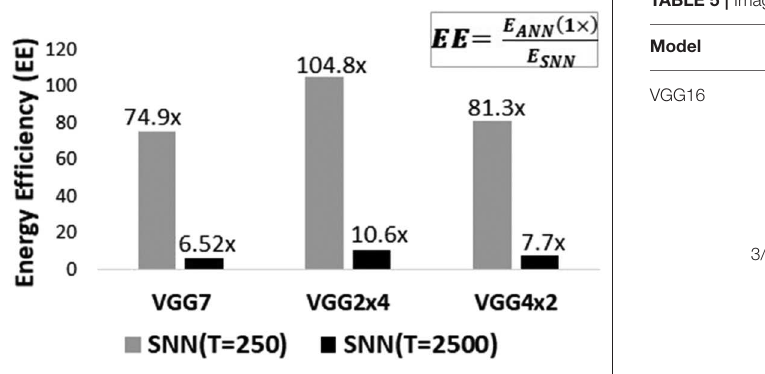
FIGURE 7 | Energy-Efficiency EE results for different SNN topologies (from Table 3 ) with/without BackRes connections trained with Conversion technique on CIFAR10 data. The efficiency values have been denoted on top of each graph for clarity. Note, EE > 1 implies E ANN > E SNN denoting lower energy consumption with SNN implementations.